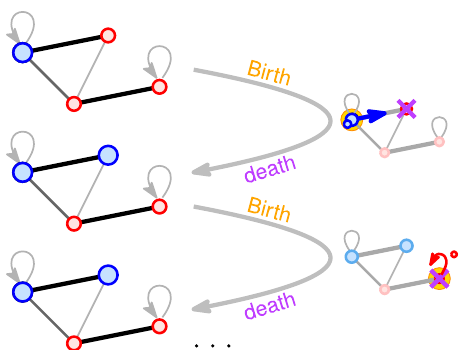
Fig. 2 Moran birth – death process on a population structure. Residents (red, with fi tness 1) and mutants (blue, with fi tness advantage r > 1) are spread over nodes of a graph. Its nodes represent sites and its weighted edges represent migration rates. At each discrete time step, one individual reproduces ( “ Birth ” , yellow) and places its offspring on a neighboring node, replacing its initial occupant ( “ Death ” , purple). Eventually, either the mutants or the residents fi xate on the